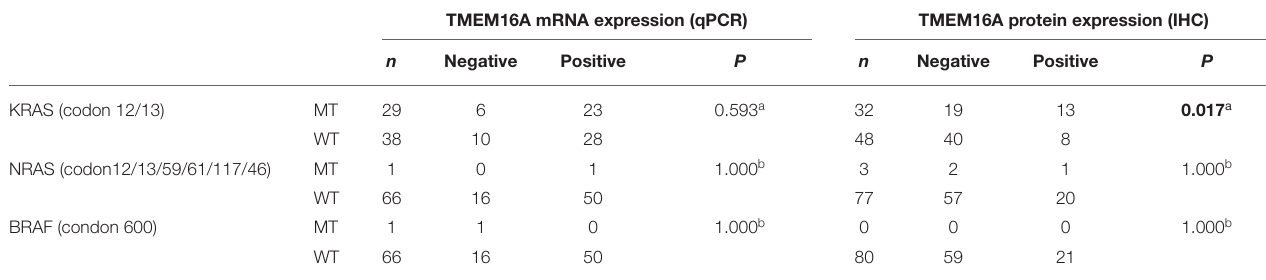
TABLE 5 | TMEM16A mRNA and protein expression according to KRAS/NRAS/BRAF mutation status in CRCs. TMEM16A mRNA expression (qPCR) TMEM16A protein expression